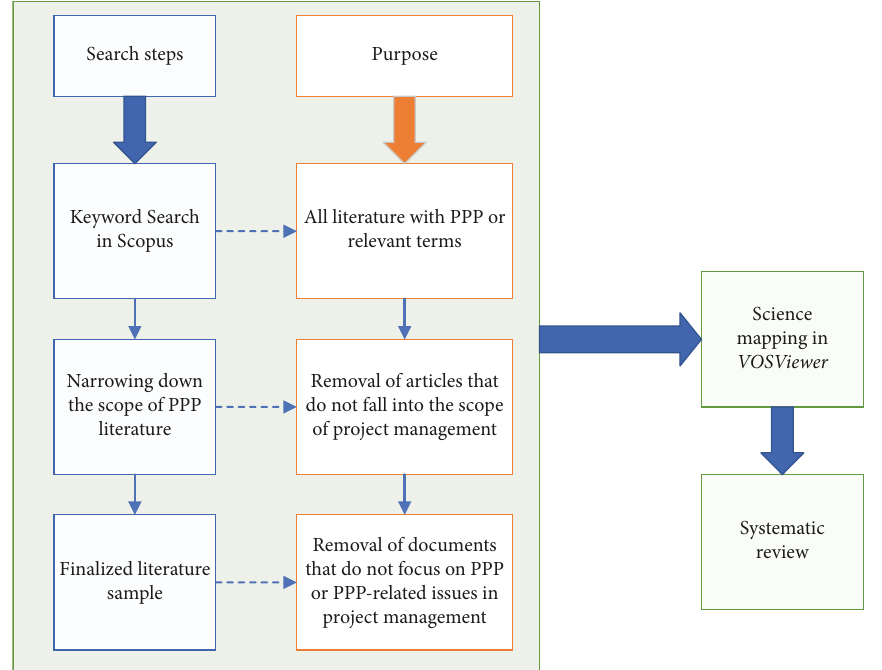
Figure 1: The description of research steps in PPP literature